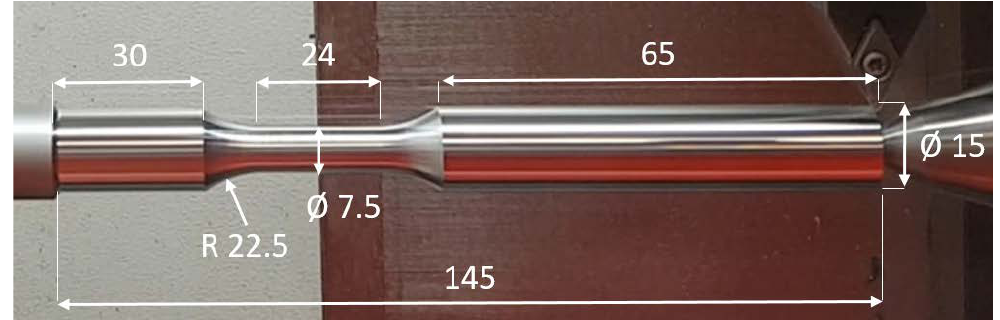
Figure 1. Specimen geometry (dimensions in mm).